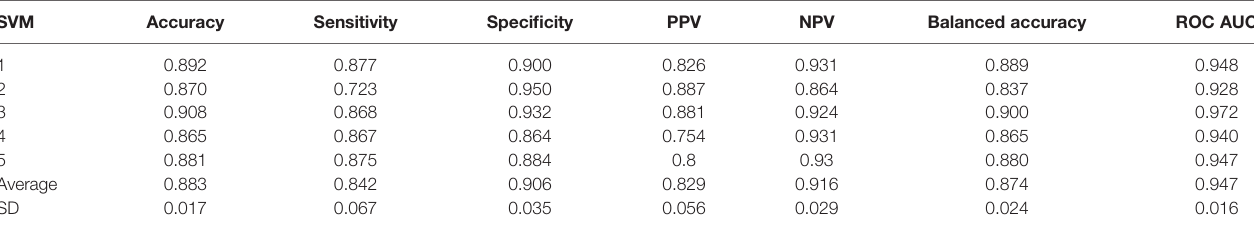
TABLE 2 | Five-fold cross-validation for the support vector machine method with 10 variables.